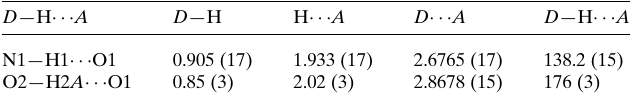
Table 1 Hydrogen-bond geometry (A˚ , (cid:4) ).